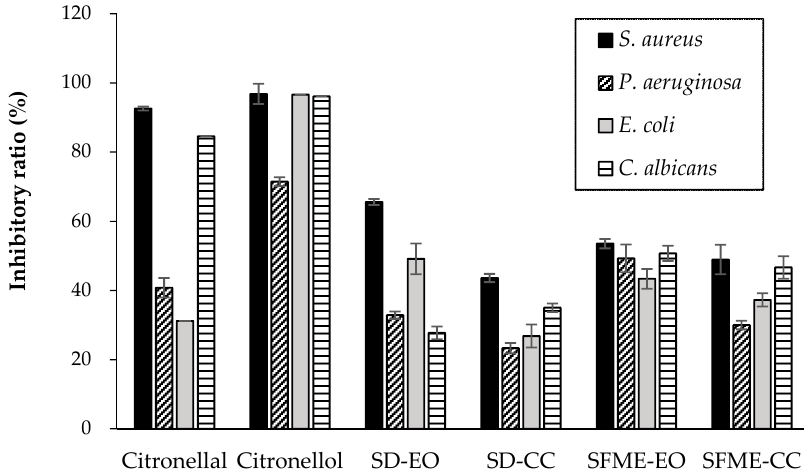
Figure 1. Inhibitory ratio (%) of ‘Mato Peiyu’ leaf essential oils (SD-EO and SFME-EO), citronellal, and citronellol against four microbial strains. SD-CC and SFME-CC were the mixtures of citronellal and citronellol, which were tested at concentrations determined according to composition ratios relative to the essential oils obtained through SD and SFME, respectively. SD-EO, SFME-EO, citronellal, and citronellol were measured at a concentration of 0.0500% ( v / v ). SD-CC and SFME-CC were measured at concentrations of 0.0254% and 0.0299% ( v / v ), respectively. Data are presented as the mean ± standard deviation based on triplicate determination.